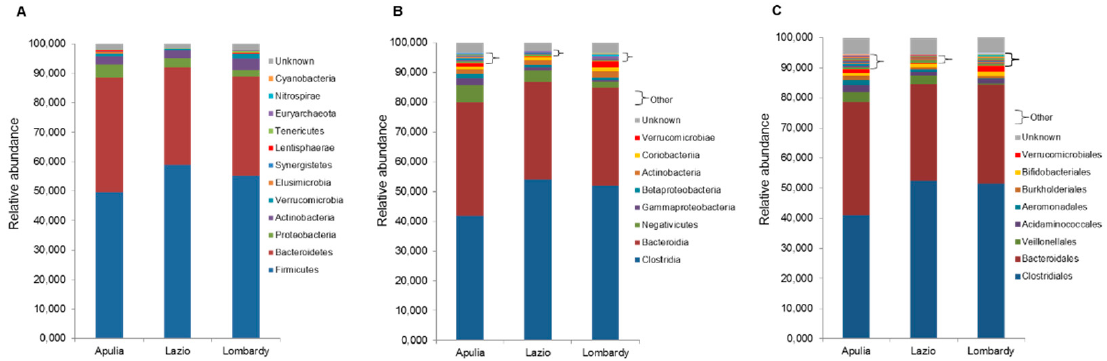
Figure 1. Microbiota composition of Italian healthy subjects grouped by regions, at the phylum ( a ), class ( b ) and order ( c ) levels. The mean value of all the detected taxa at each level is represented.